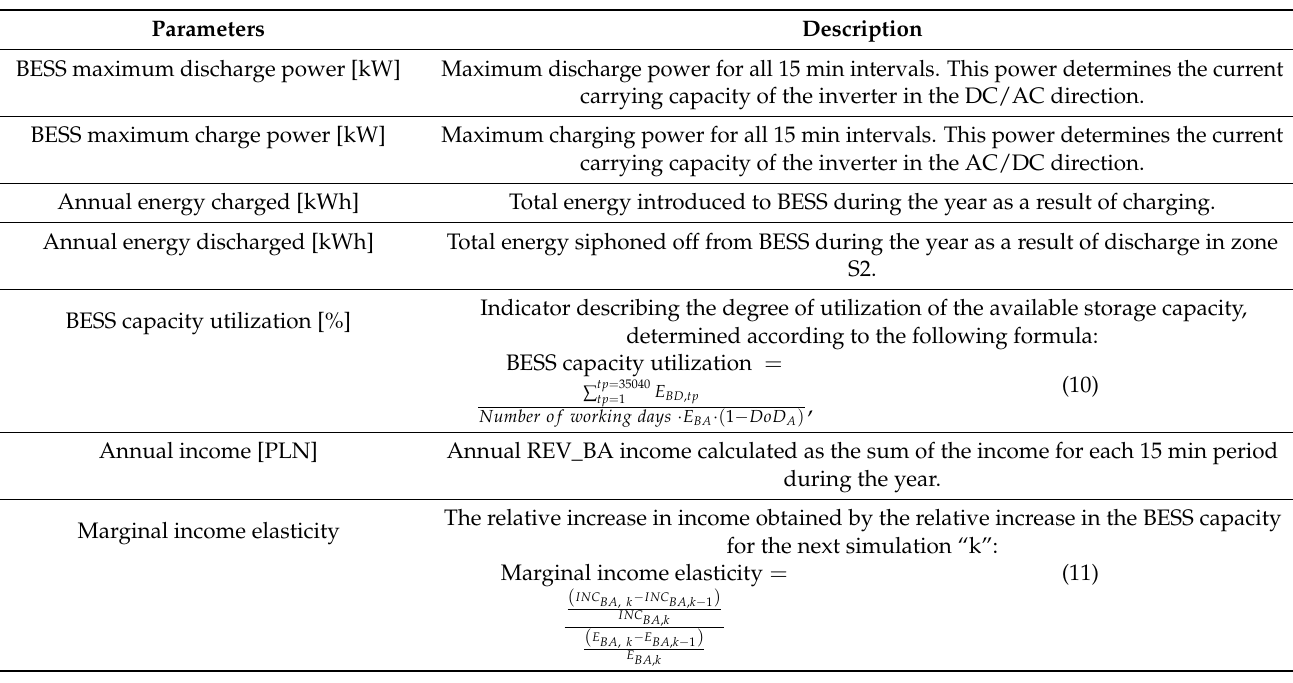
Table 4. Measures for the evaluation of the functioning of subsequent BESS figures for the implemen- tation of the price arbitrage